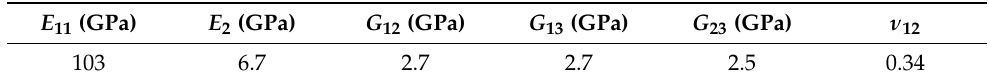
Figure 1. ( a ) Longitudinal view and ( b ) cross-sectional area view of the carbon fiber. Table 1. Lamina properties for the carbon/epoxy composite used in this study [18].